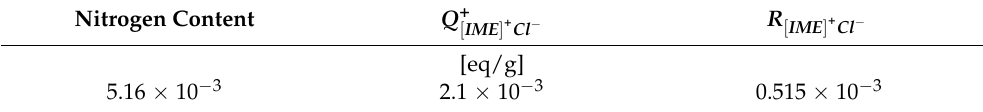
Table 3. Summary of data for [IME] + Cl − copolymer.